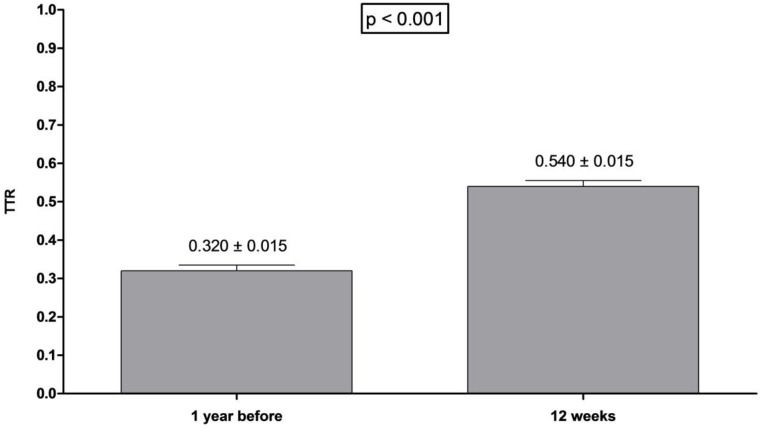
Comparison between TTR of 1 year before and 12 weeks in patients included at the protocol. Wilcoxon signed-rank test was performed. Data are expressed as mean ± SE. TTR of 1 year before was calculated for the period of 1 year prior to the patient entering the protocol. TTR of 12 weeks was calculated 12 weeks after protocol start.